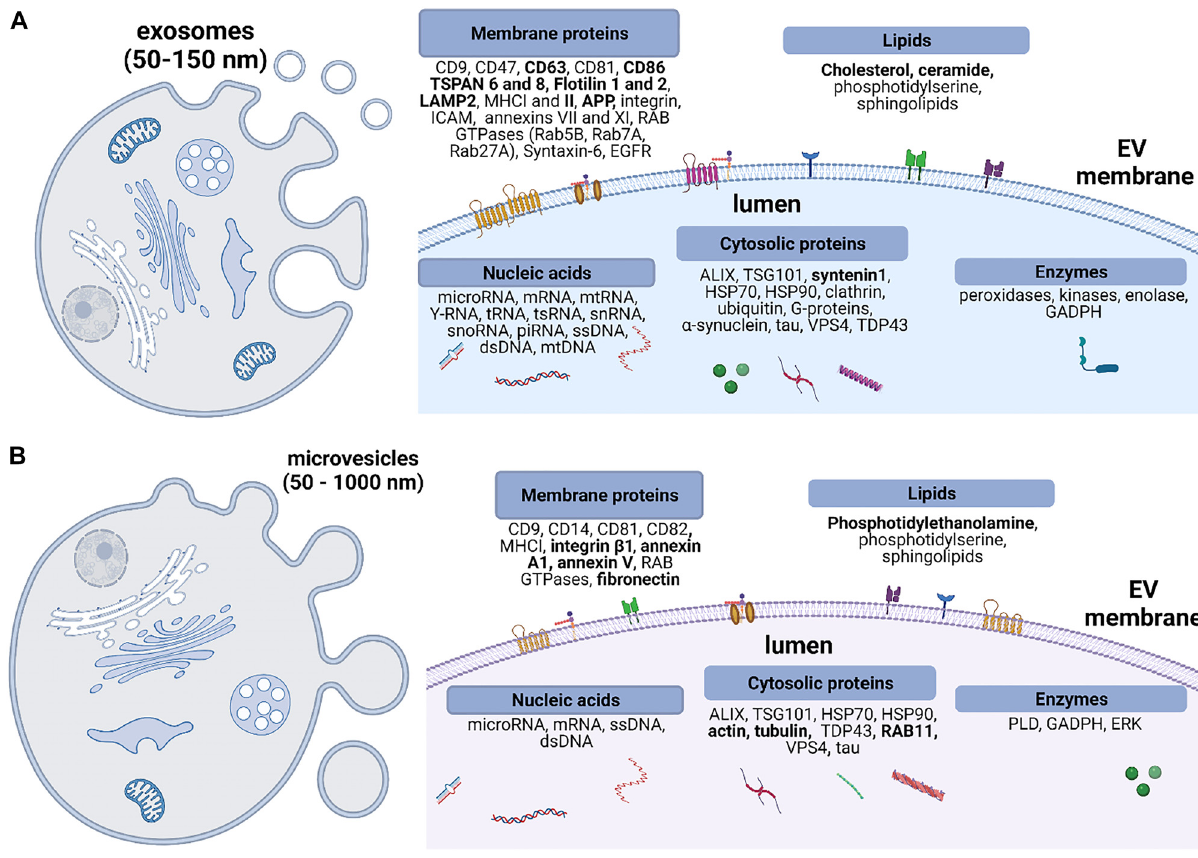
Figure 2: Biogenesis and chemical composition of a single EV. (A) Exosomes are released upon fusion of multivesicular bodies (MVBs) to an extracellular matrix. Exosomes have a phospholipid bilayer membraneandcarryvariousspeciesofproteins,nucleicacids,andmetabolites.(B)Microvesiclesform via outwardbuddingofthecellplasma membrane. Their biochemical content has some similarities with exosomes ’ and includes a variety of membrane proteins, cytosolic proteins, lipids, and nucleic acids. Bold fonts in both panels represent EVs molecular cargo that is uniquely found or enriched either in exosomes or in microvesicles. TSPAN, tetraspanins; APP, amyloid precursor protein; LAMP2, lysosomal associated membrane protein 2; MHC, major histocompatibility complex; ICAM, intercellular adhesion molecule; EGFR, epidermal growth factor receptor; ALIX, ALG-2 interacting protein; TSG101, tumor susceptibility gene 101 protein; HSP, heat shock protein; VPS, vacuolar soring associated protein; TDP43, TAR DNA-binding protein 43; GADPH, glyceraldehyde-3-phosphate dehydrogenase; PLD, phospholipase D; ERK, extracellular receptor